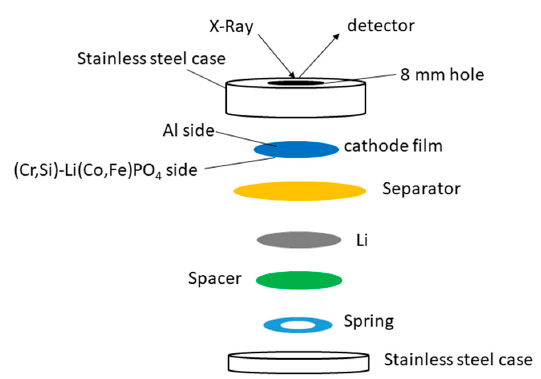
Figure 1. A schematic diagram of in situ XRD cell.